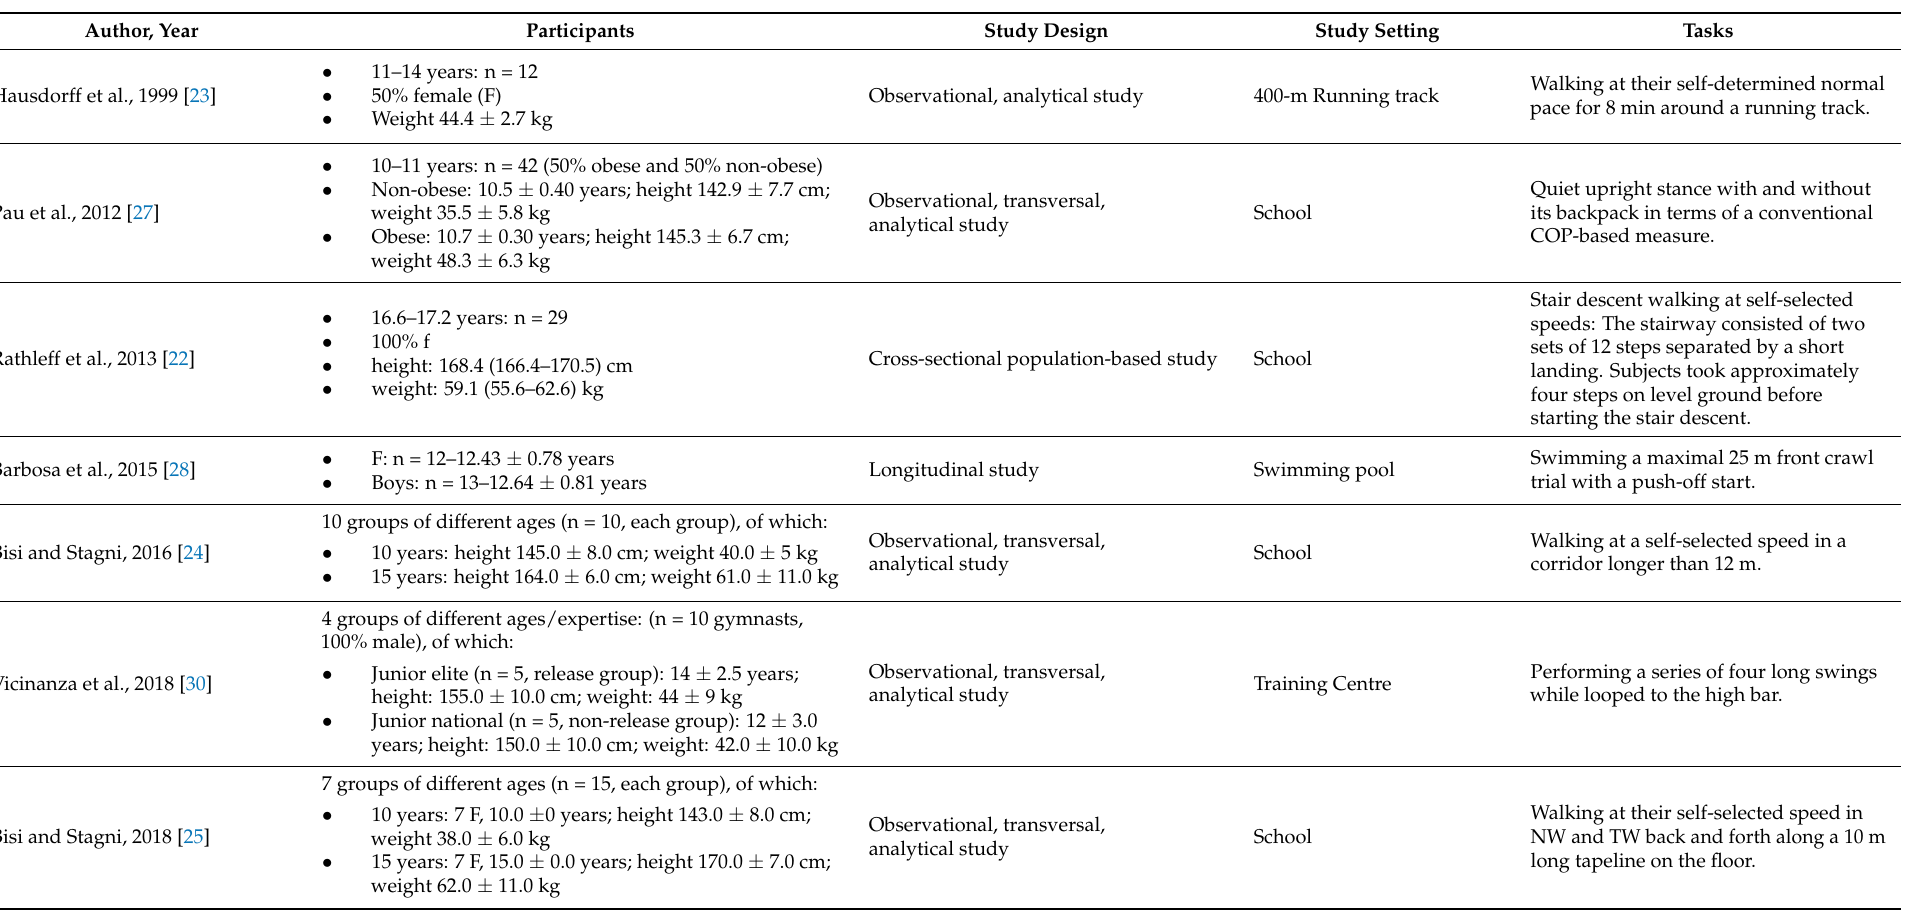
Table 2. Characteristics of the participants, study design, study setting, and